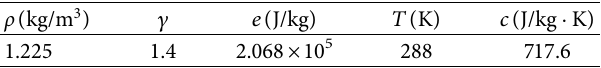
Table 2: Material parameters of air under standard